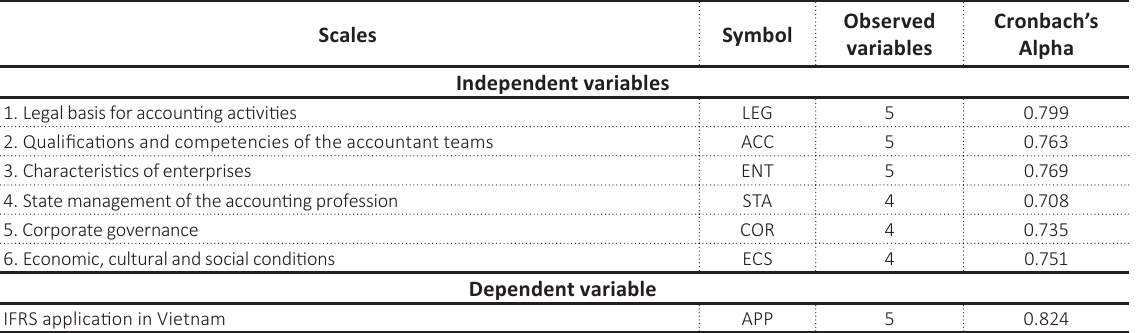
Table 2. Cronbach’s Alpha test results of